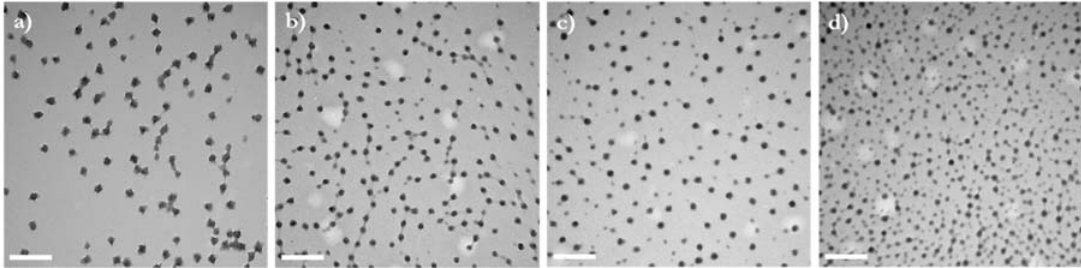
Figure 3. TEM pictures showing the morphology of nanogels with a DH of 30% and synthesized using various MC molecular weights: ( a ) 30 kg/mol, ( b ) 85 kg/mol, ( c ) 165 kg/mol, ( d ) 230 kg/mol. The scale bars indicate 500 nm.